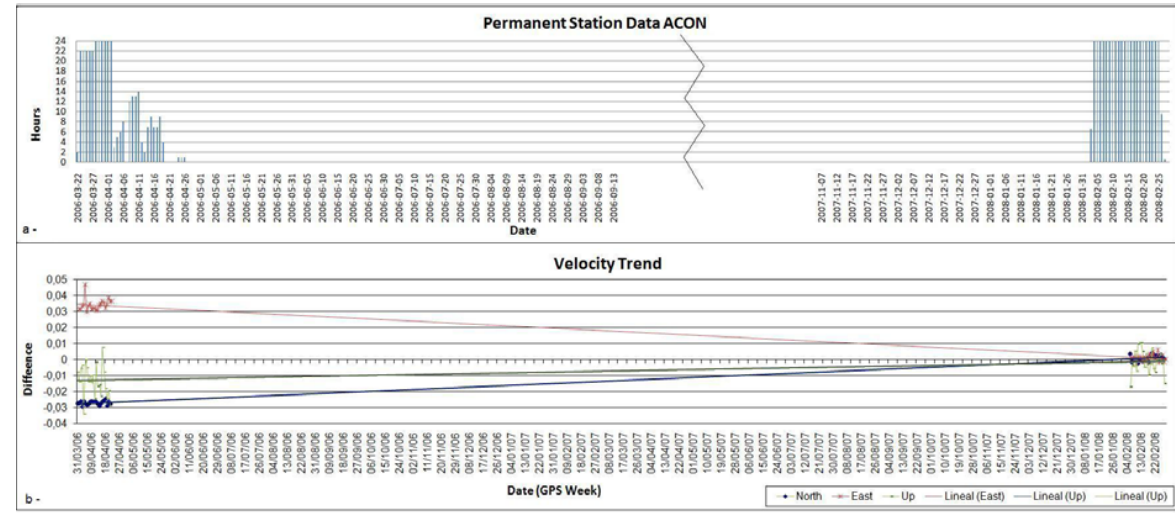
Figure 2. Station ACON. Data Transmission from the Summit